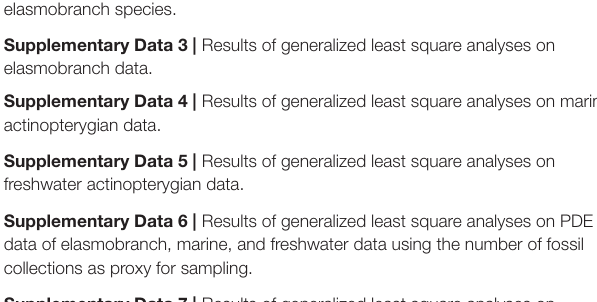
Supplementary Data 1 | Abiotic and diversity data used in the analyses.